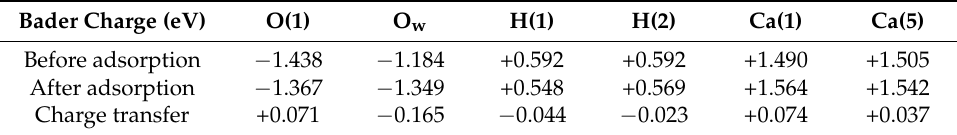
Table 4. Bader charge of bonding atoms before and after water adsorption from AC4.